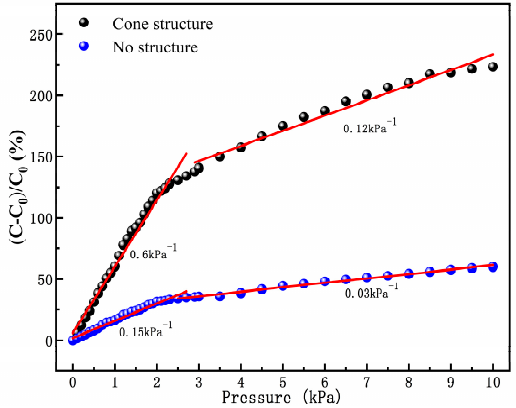
Figure 6. Pressure–response curves for microstructural and non-microstructural.